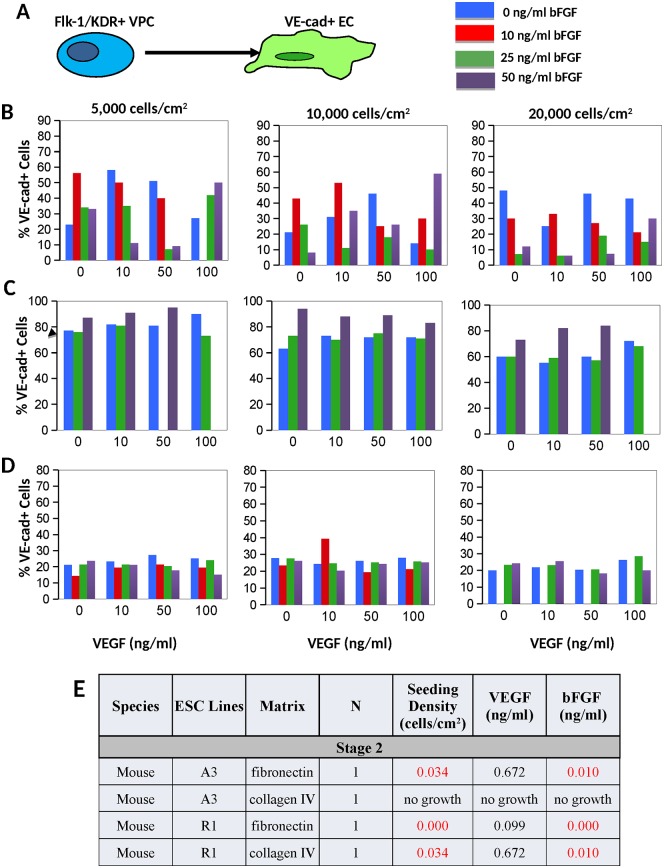
Results from stage 2 inductions of mouse ESC.A) VPC were induced into VE-cad+ EC. B) Results of differentiating mESC-A3 VPC on fibronectin (N = 1). The A3-ESC Flk-1+ VPC failed to adhere to the collagen type-IV substrate, so no data is available for that condition. Results of differentiating mESC-R1 VPC on C) fibronectin (N = 1), and D) collagen IV (N = 1). E) Based on regression analyses, P-values are provided for stage 2 mESC inductions, with statistical significance (p < 0.05, highlighted in red). The seeding density and bFGF treatment level were both found to be statistically significant variables, but not VEGF treatment levels.